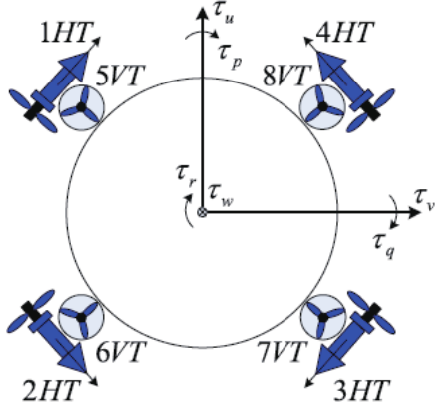
Figure 3. The thruster configuration of ODIN